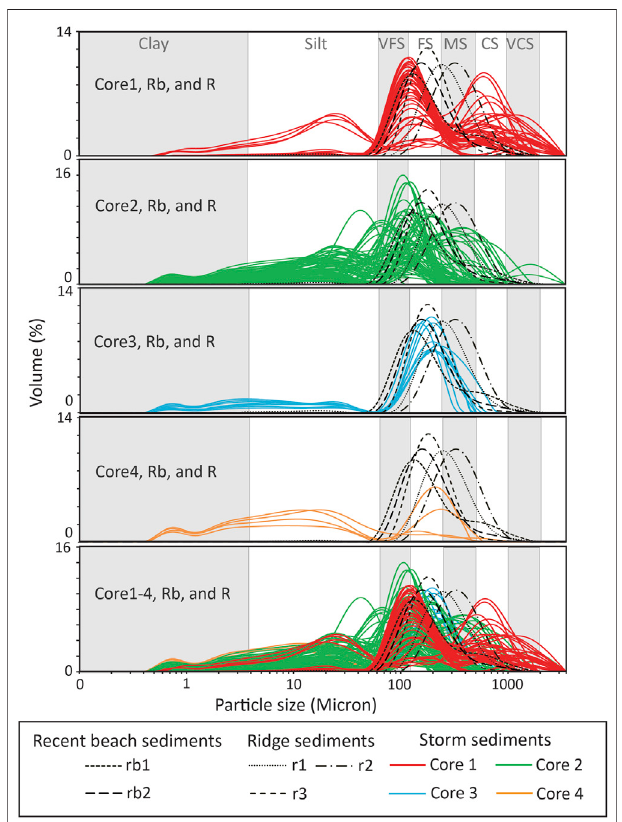
FIGURE 9 | Plots of the particle size distribution curves of candidate storm sand in comparison with the shore-normal beach deposit. Normal beach deposits showed only a unimodal distribution, whereas curves of the candidate storm deposits were clearly displayed as a unimodal, bimodal and multimodal